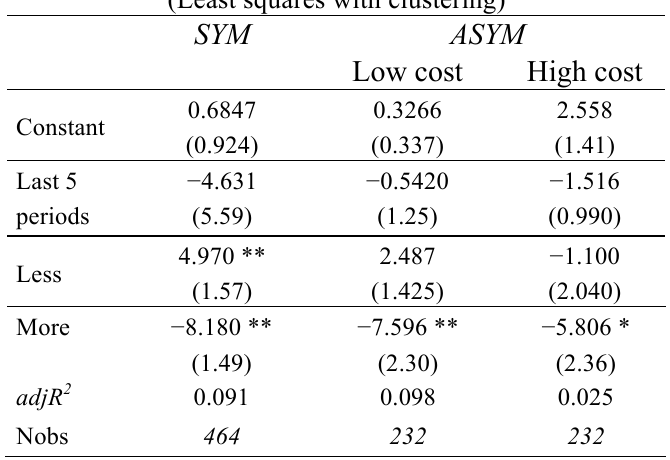
Table 4. Change in effort in the ENFORCED SYM and ASYM